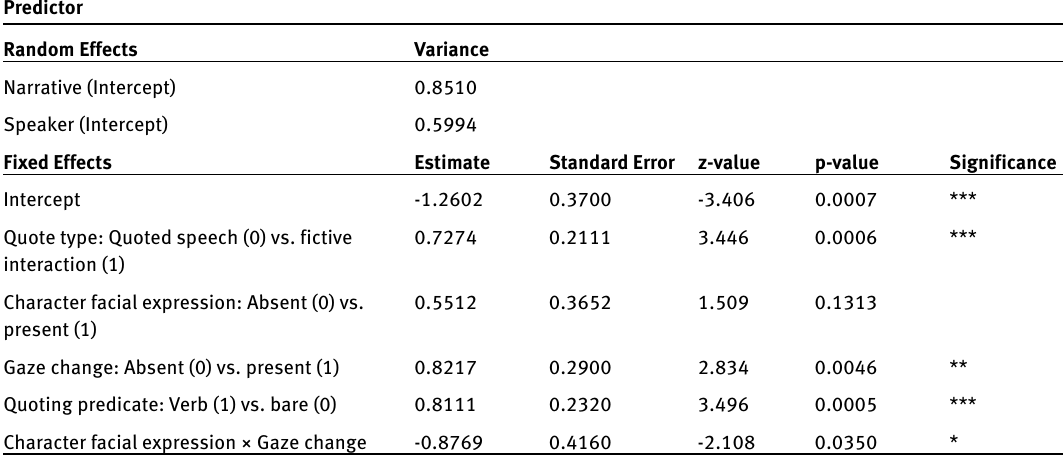
Table 8: The best generalized mixed-effects regression model for Quote Islands. Only predictors for the best-fit model are shown. Negative estimates indicate lower probability. Significance is indicated as follows: *** indicates p < 0.001, ** p < 0.01, * p < 0.05 and . p <